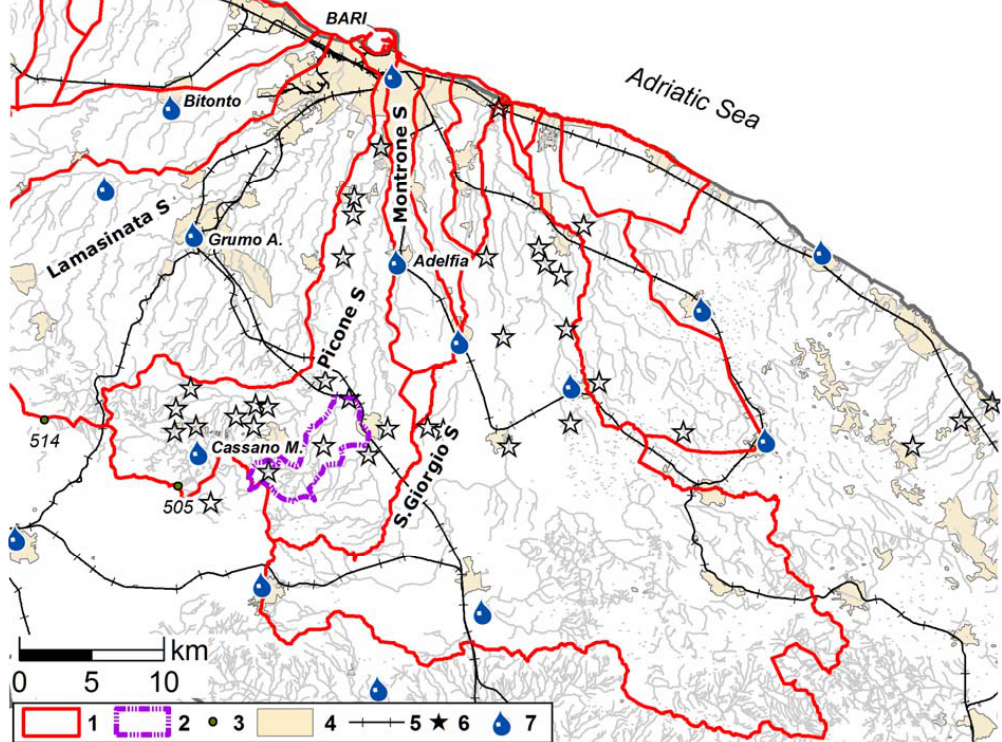
Figure 2 - Schematic map of streams, catchments, railways, roads, and damages. 1) main 3 Fig. 2. Schematic map of streams, catchments, railways, roads, and damages. (1) main catchments (natural morphology, not considering artificial channels); (2) selected sub-catchment (Scappagrano Stream); (3) benchmark (ma.s.l.); (4) urbanised areas; (5) railways; (6) location catchments (natural morphology, not considering artificial channels); 2) selected sub-4 of main damage of 2005 flood event, (7) rain catchment (Scappagrano Stream); 3) benchmark (m asl); 4) urbanised areas; 5) railways; 6) 5 location of main damage of 2005 flood event, 7) rain gauges. 6